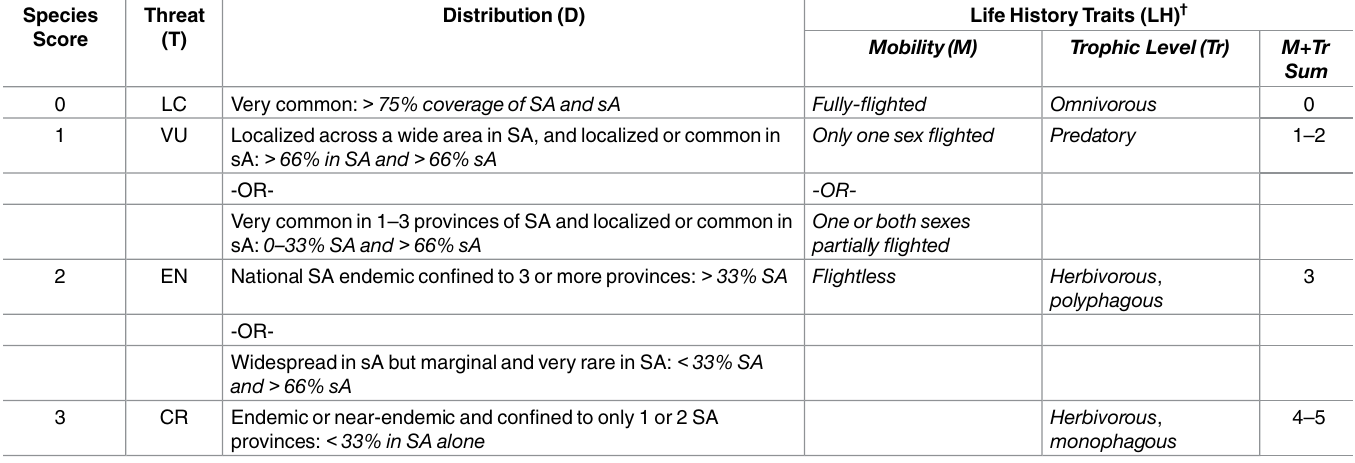
Table 1. SouthAfricankatydidscoringchartto enablecomparison of species on the basisof threecriteria:threat,distributionand life history traits.